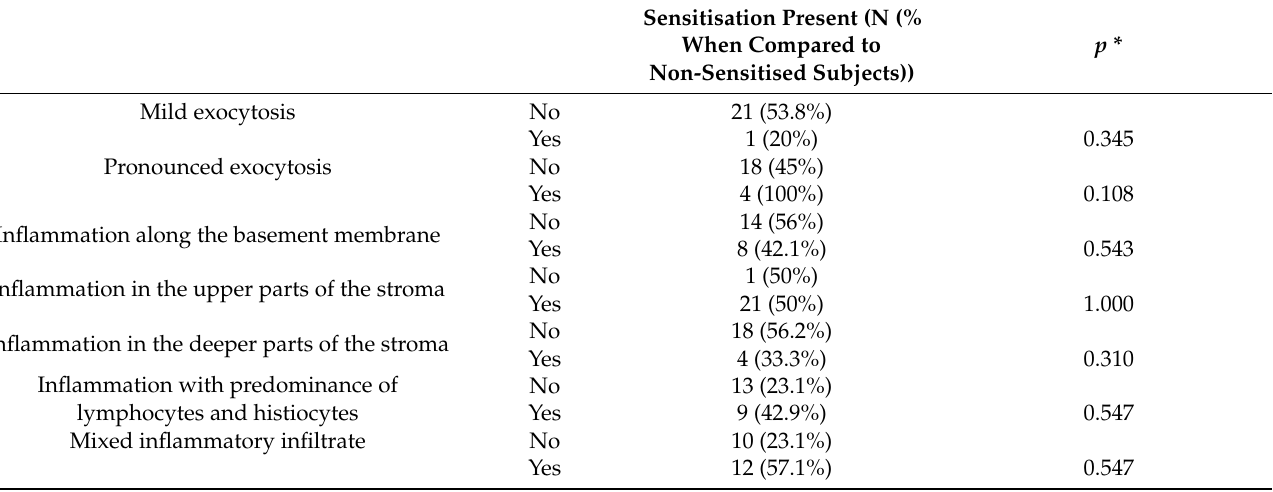
Table 3. Comparison of histopathological findings of gingival inflammation and inflammatory cells of sensitised when compared to non-sensitised subjects.